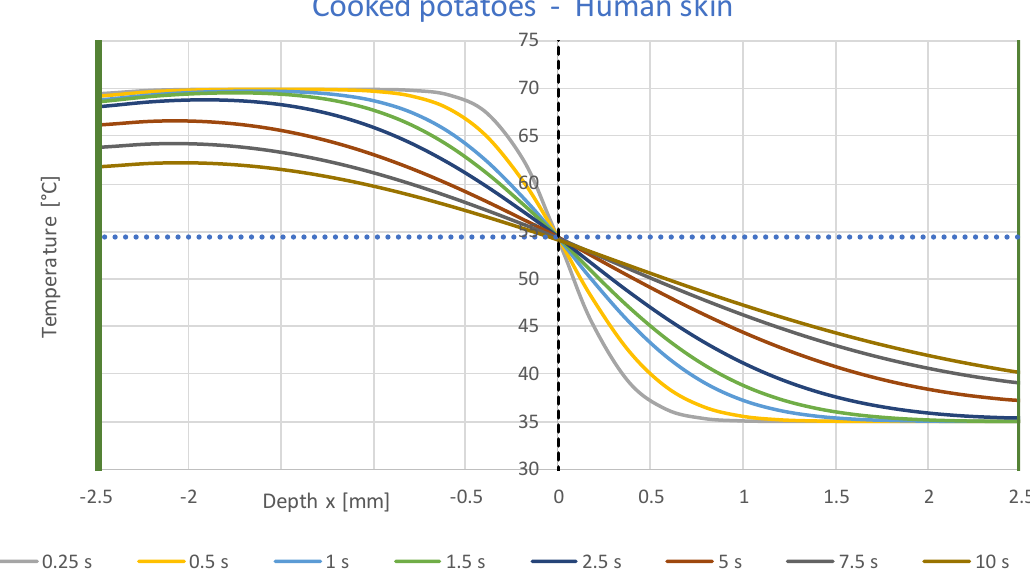
Figure 6. Temperature profiles for equal times t from 0.25 s to 10 s above the local coordinate x for a cylindrical sample of boiled potatoes 2.5 mm thick and 70 °C starting temperature in contact with the tongue. Tongue temperature: 35 °C.